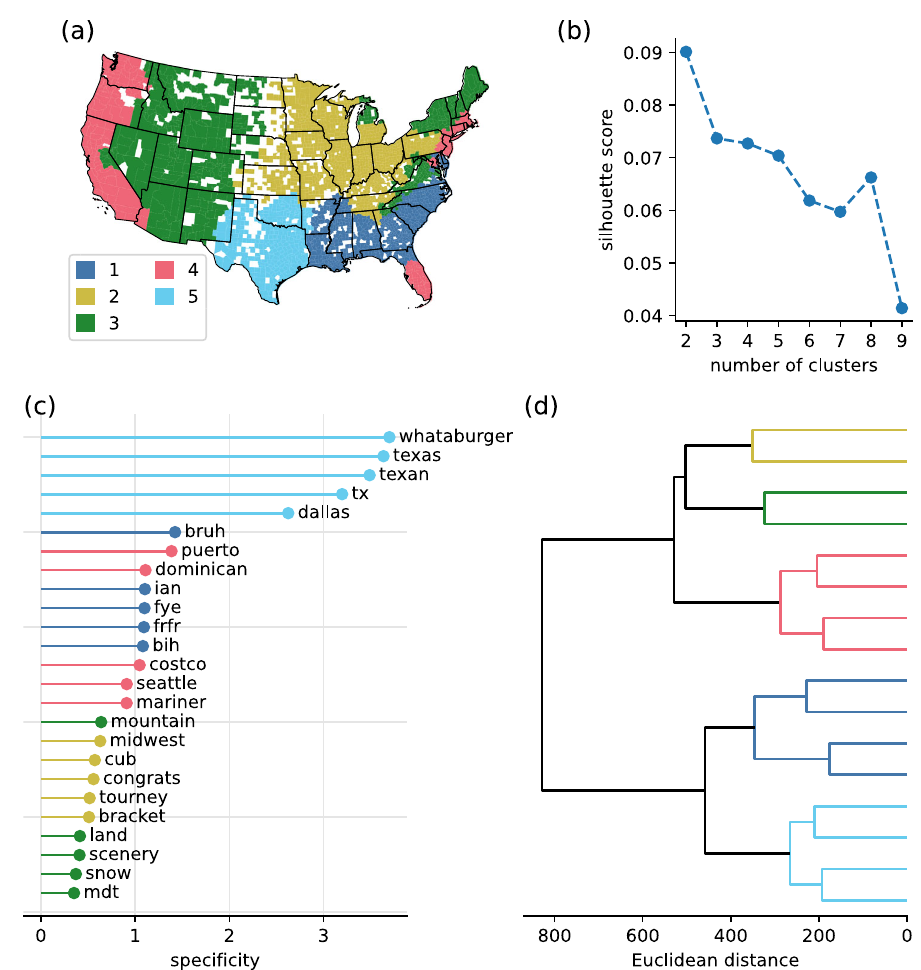
Fig. 4 Cultural regions obtained from our whole dataset. a Map of the fi ve clusters obtained through hierarchical clustering, selected from a high value of b the mean Silhouette score. A signi fi cant drop in the Silhouette score after 5 levels indicates that further splitting counties into more regions do not yield coherent cultural regions. c Five most speci fi c words for the fi ve clusters shown in a , along with their speci fi city values. d The dendrogram allows seeing which clusters are fi rst joined if going to a higher level of clustering, and thus which ones are closer together. It clearly shows that the strongest division is the one between the North and the Southeast (excluding Florida) with further splittings as the cluster distance